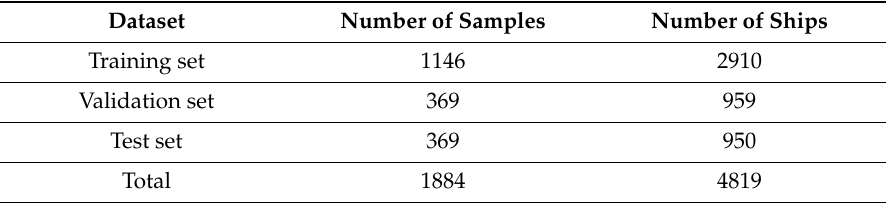
Table 1. The division of data set for ship detection in remote-sensing images (DSDR).